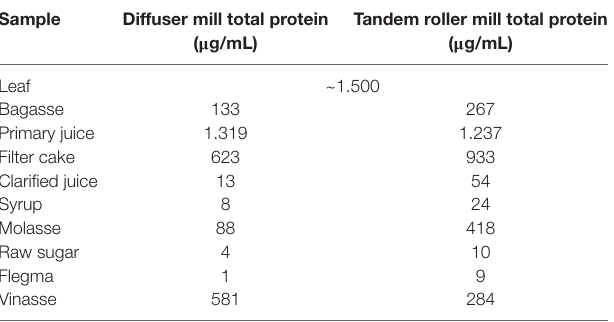
TaBle 14 | Total protein quantification using BCA in fraction collected from two types of mills.